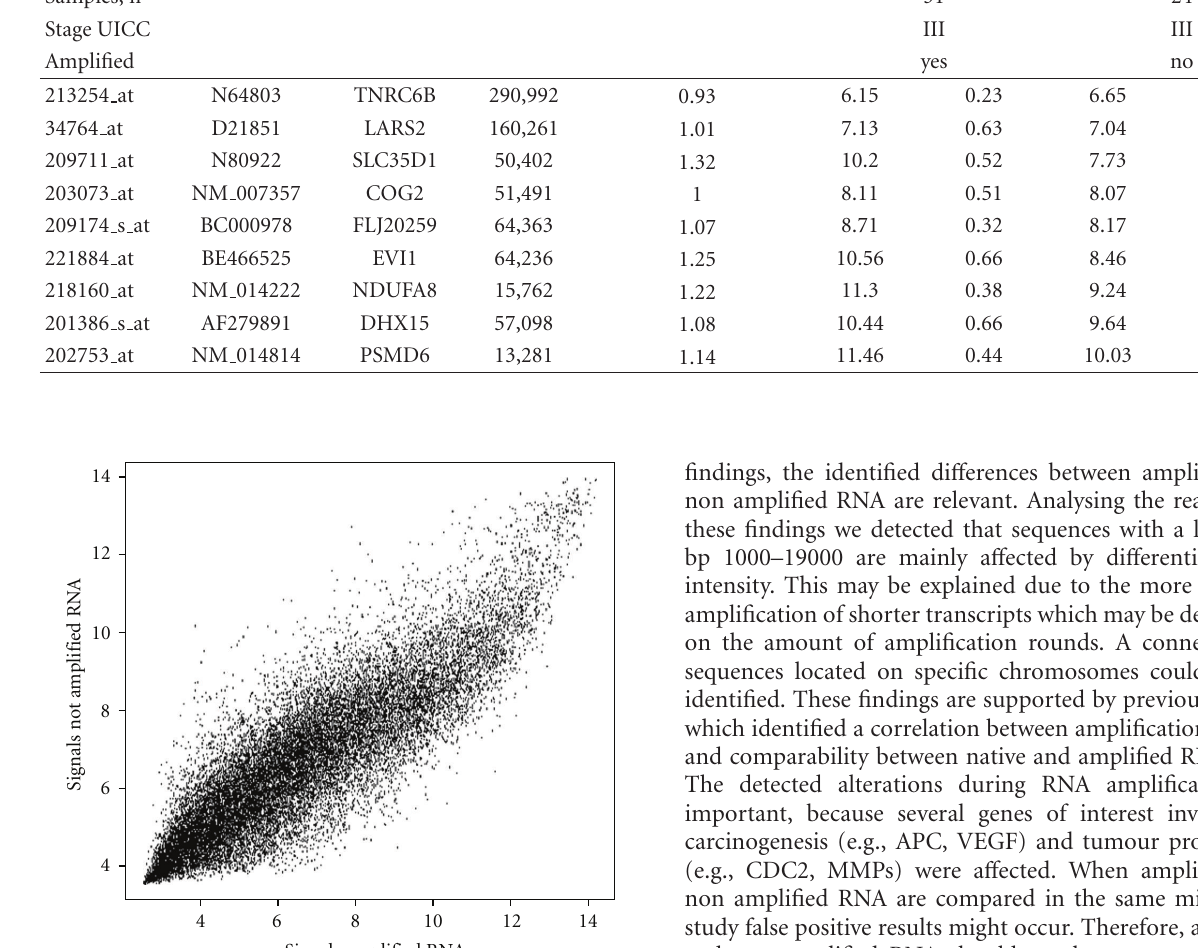
Figure 4: Comparison of mean signals (HG-U 133A, A ff ymetrix) between RNA samples of 31 colon carcinomas amplified and 24 RNA samples of colon carcinomas not amplified prior to microarray